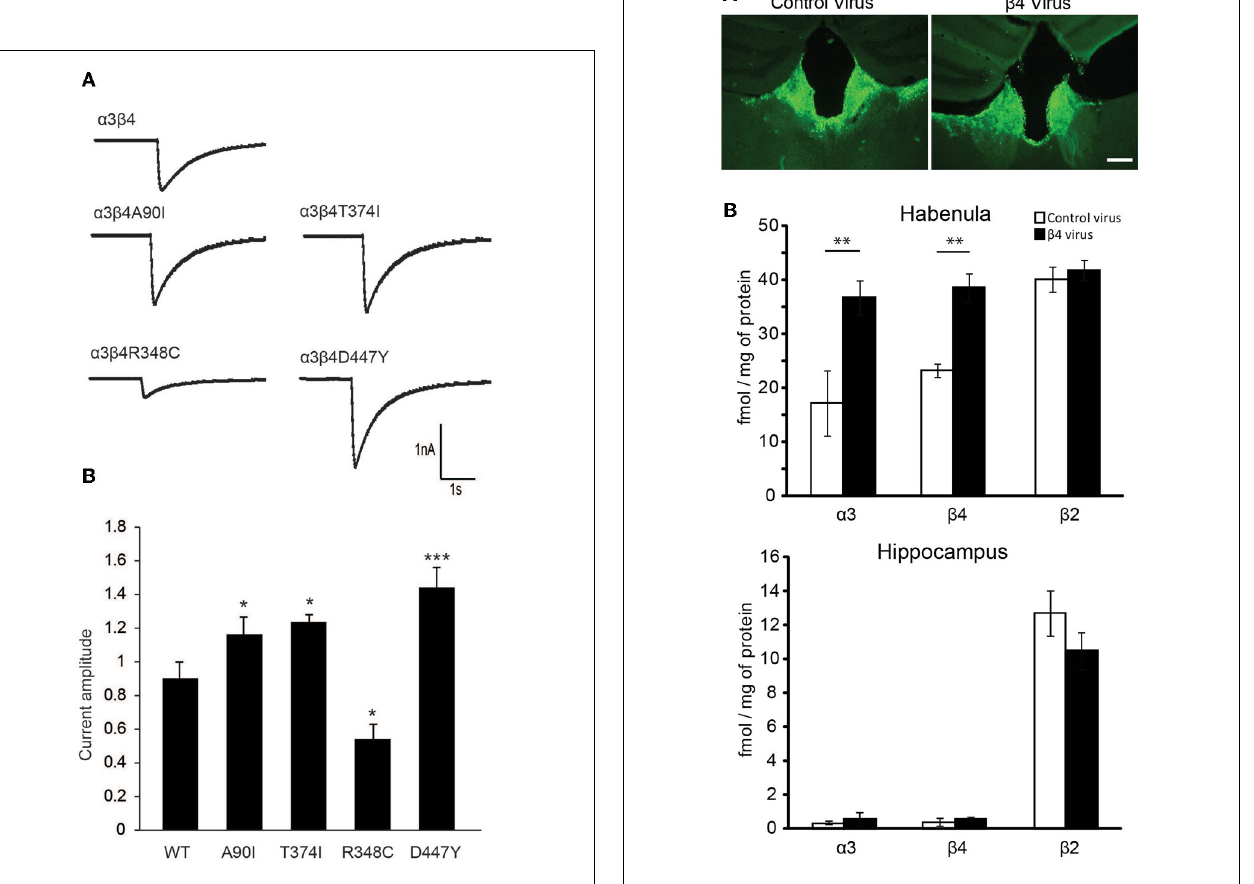
FIGURE 4 | Electrophysiological characterization of β 4 variants in primary rat hippocampal neurons. (A) Representative traces of nicotine-elicited currents in primary hippocampal neurons transduced with α 3- and β 4-carrying lentivirus (B) Quantification of nicotine-evoked currents show increased response when neurons were transduced with A90I, T374I, or D447Y β 4 variants, while neurons transduced with point mutation R348C resulted in decreased response to nicotine ( n = 15–22 neurons per condition). All values are expressed as mean ± s.e.m. One-Way ANOVA F ( 4 , 79 ) = 14 . 58, p < 0 . 0001; Dunnett’s Multiple Comparison post-hoc ∗ p < 0 . 05, ∗∗∗ p < 0 . 001.